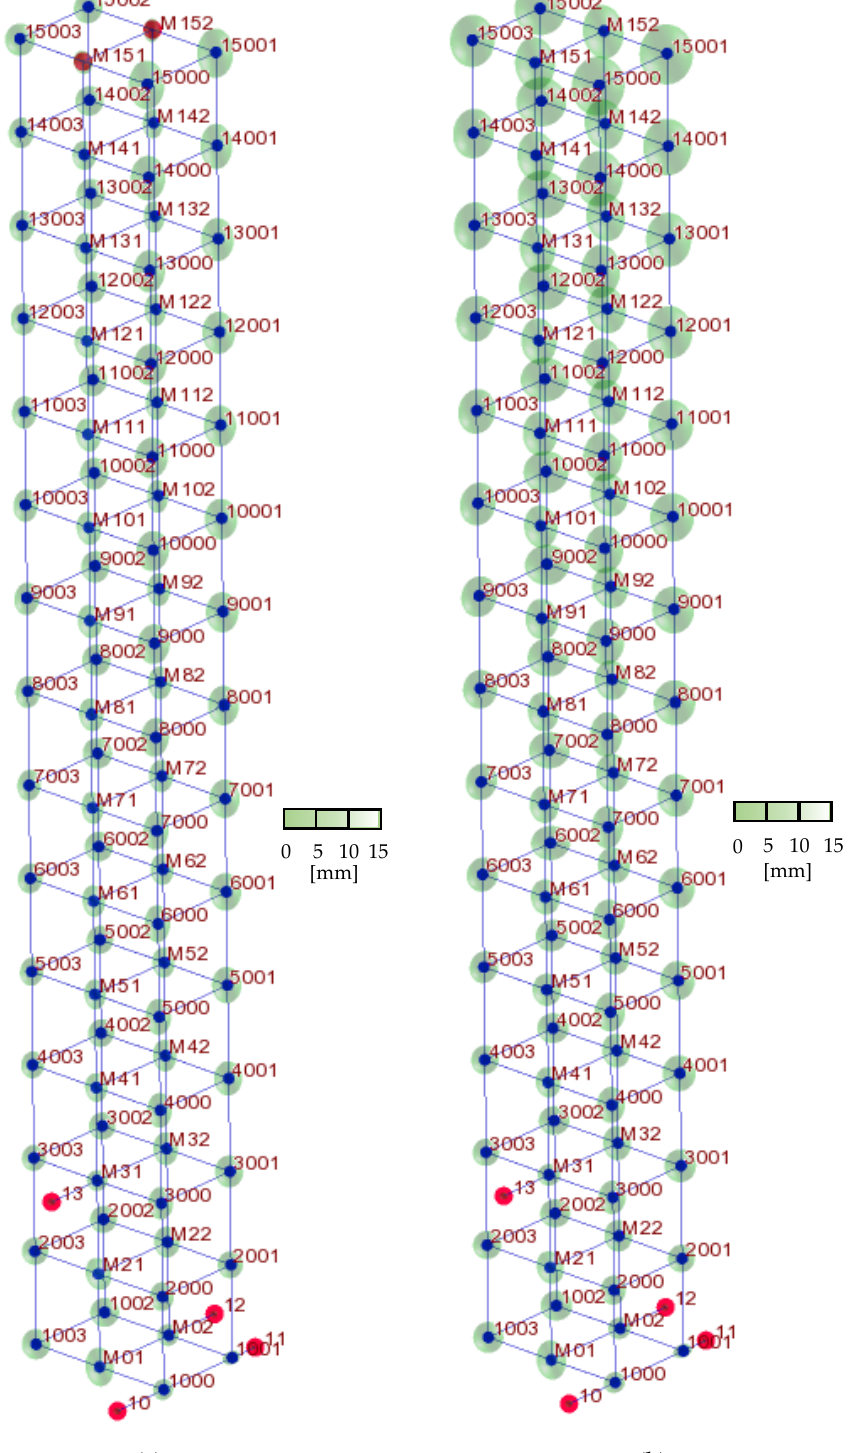
Figure A1. The absolute error ellipses of coordinate determination ( a ) with additional GNSS observations; ( b ) without additional GNSS observations.